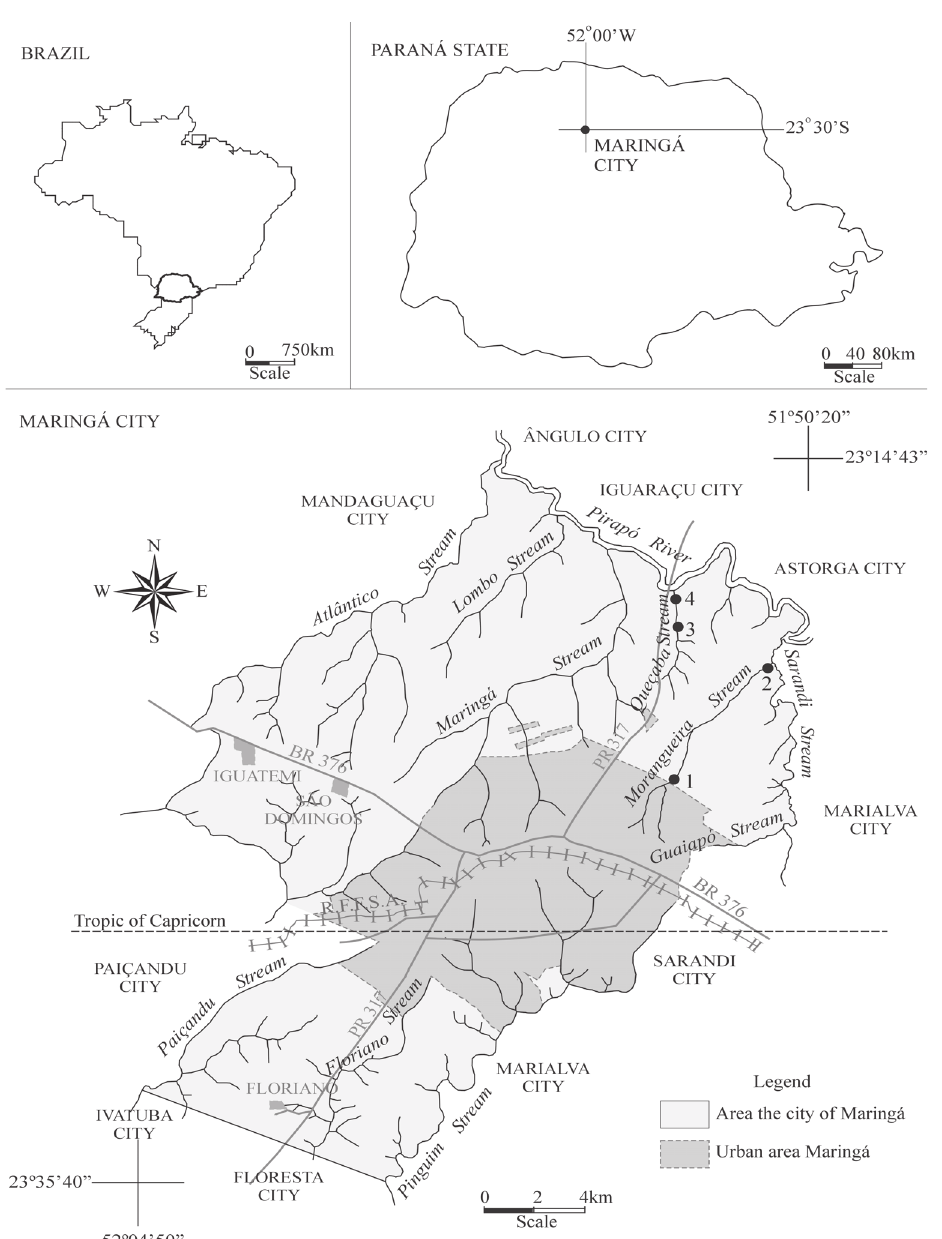
Figure 1. Sampling sites for the Queçaba and Morangueiro streams in the state of Paraná,